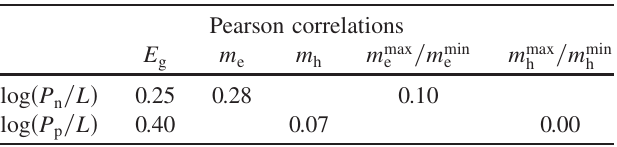
TABLE II. Calculated Pearson correlations between the nor- malized power factor and other properties: band gap ( E carriers’ effective mass ( m mum and minimum effective masses. Power factor is positively correlated to most of these properties.